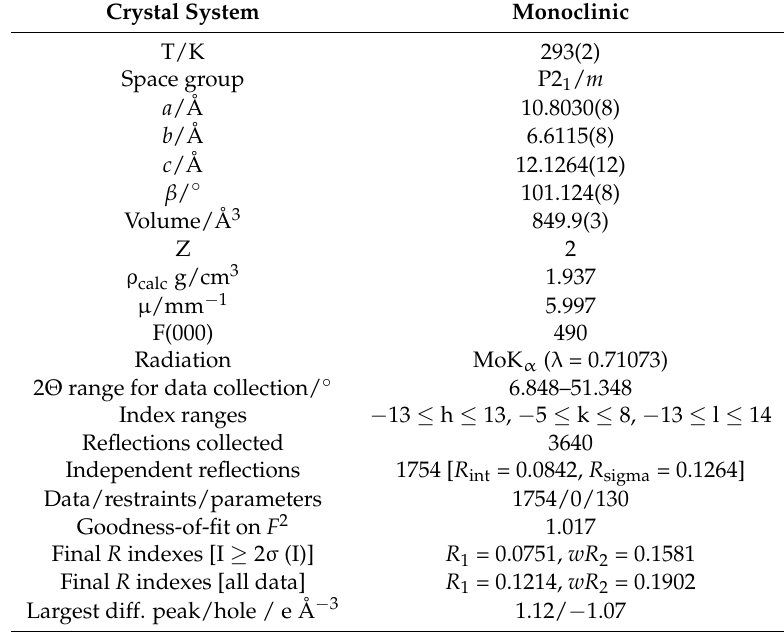
Figure 1. Thermal ellipsoid drawing (50% probability level) of the asymmetric unit of 1 . Table 1. Crystal data and structure refinement parameters for 1 .